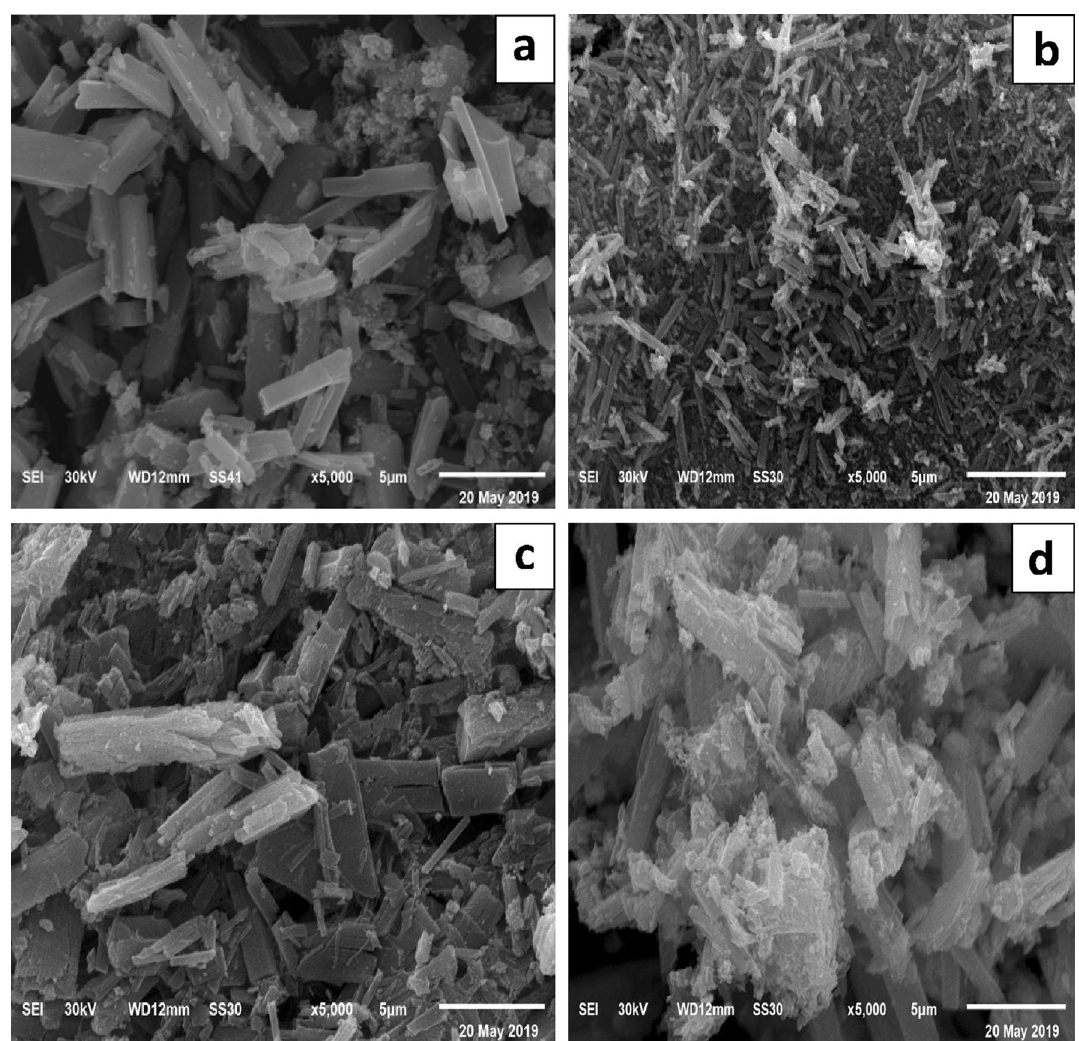
Figure 5. SEM images for ( a ) ZnO, ( b ) ZnO/5PVA, ( c ) ZnO/7PVA and ( d ) ZnO/10PVA calcined at 400 °C.